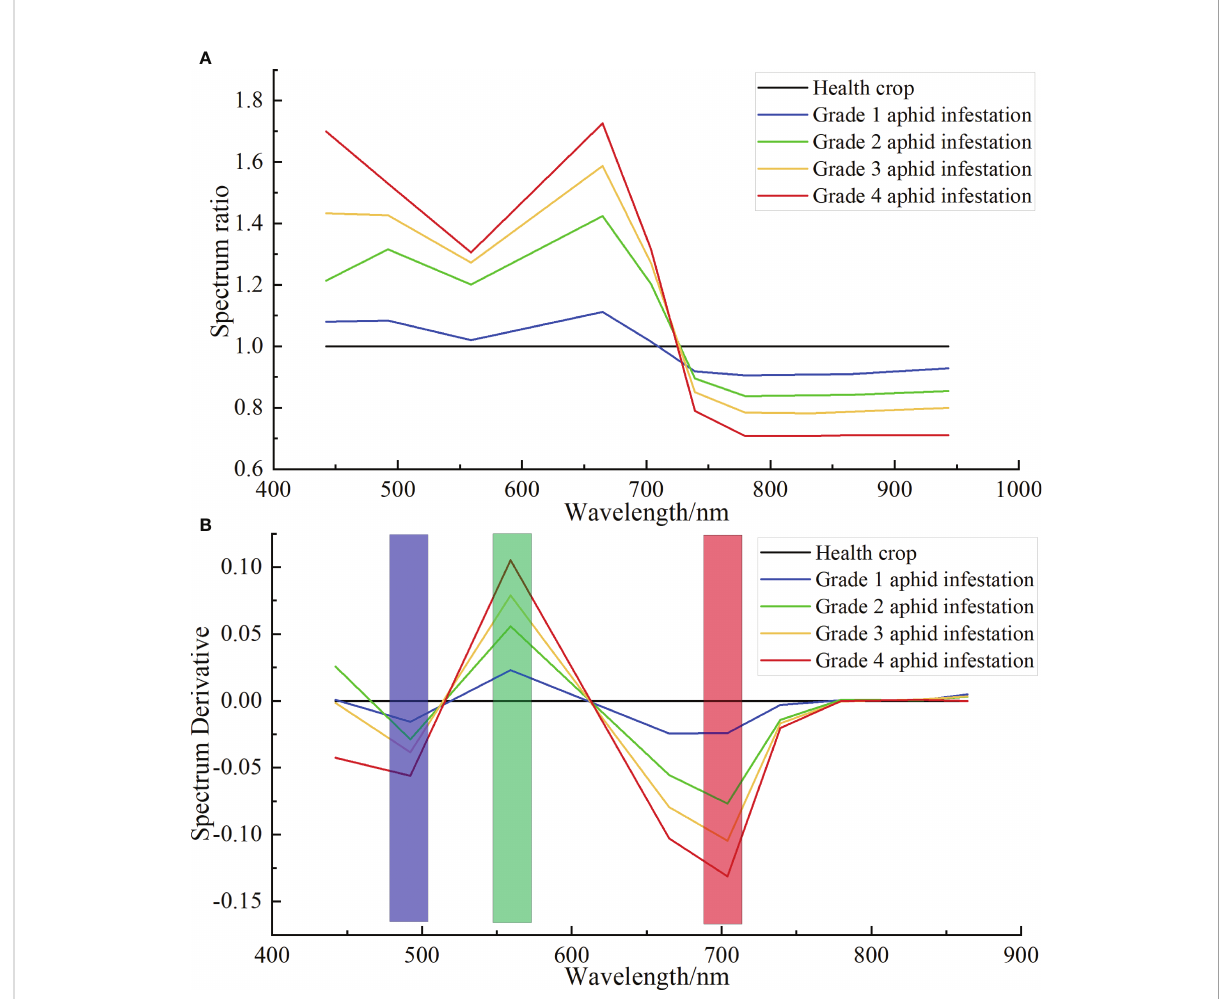
FIGURE 7 DRS results of ASD hyperspectral resampling of cotton aphid infestation at different grades. (A) Ratio spectra of cotton plants infested by different grades of aphids to healthy plants. (B) DRS of cotton plants infested by different grades of aphids to healthy